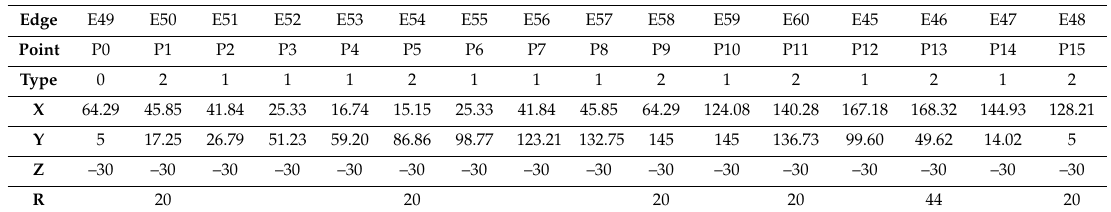
Figure 8. Cutting simulation for contour features in CNC control system using Fanuc 21: ( a ) rough machining toolpaths; ( b ) finish machining toolpaths. Table 6. The profile extraction results from Table 7. Relevant toolsets for rough contour machining.